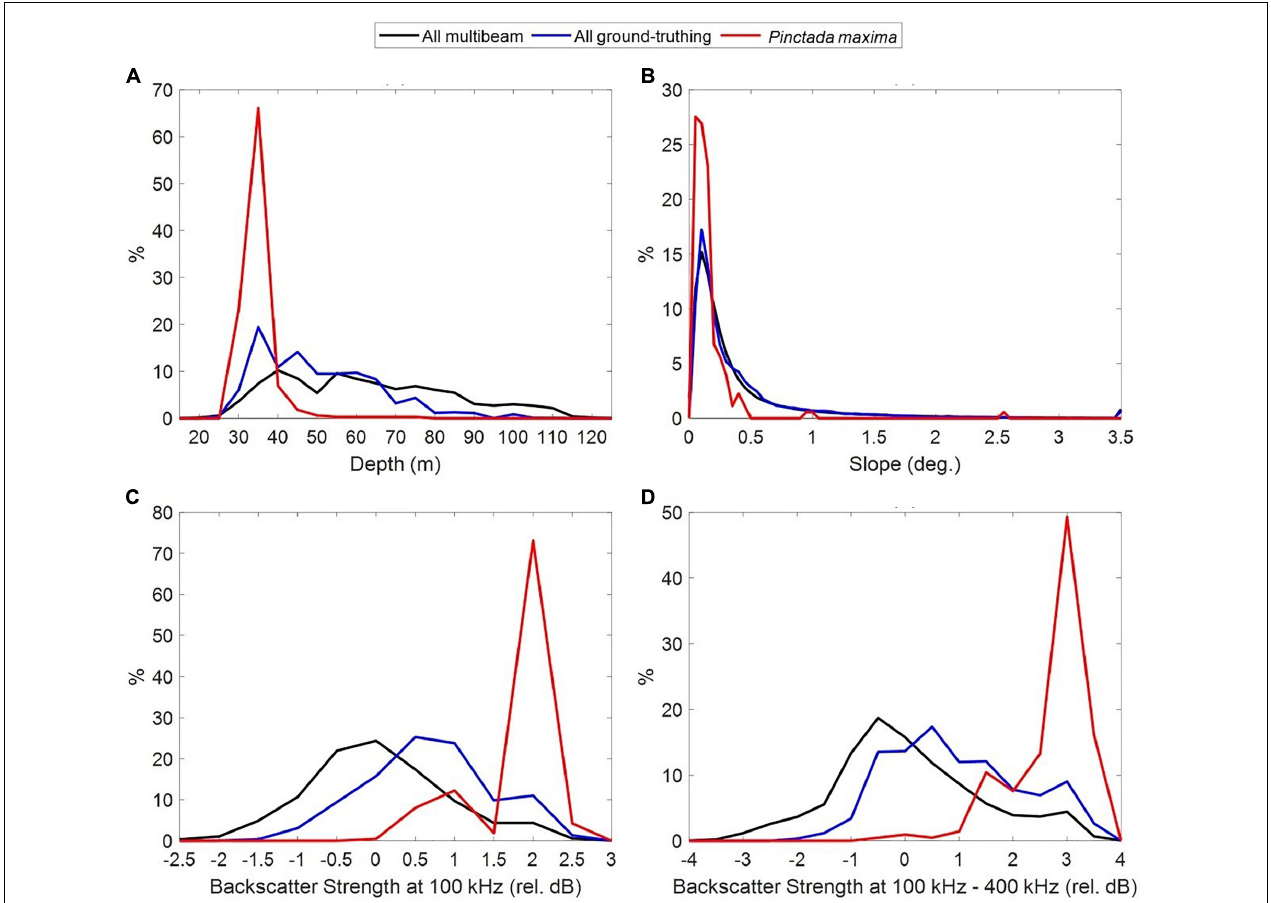
FIGURE 5 | Frequency of oyster observations (in red) relative to multibeam sampling effort and ground-truthing (towed video + sled sampling) across depth (A) , seabed slope (B) and multibeam backscatter levels at 100 kHz (relative dB normalised by STD) (C) and the difference in backscatter levels collected at 100 and 400 kHz (relative dB normalised by STD) (D)